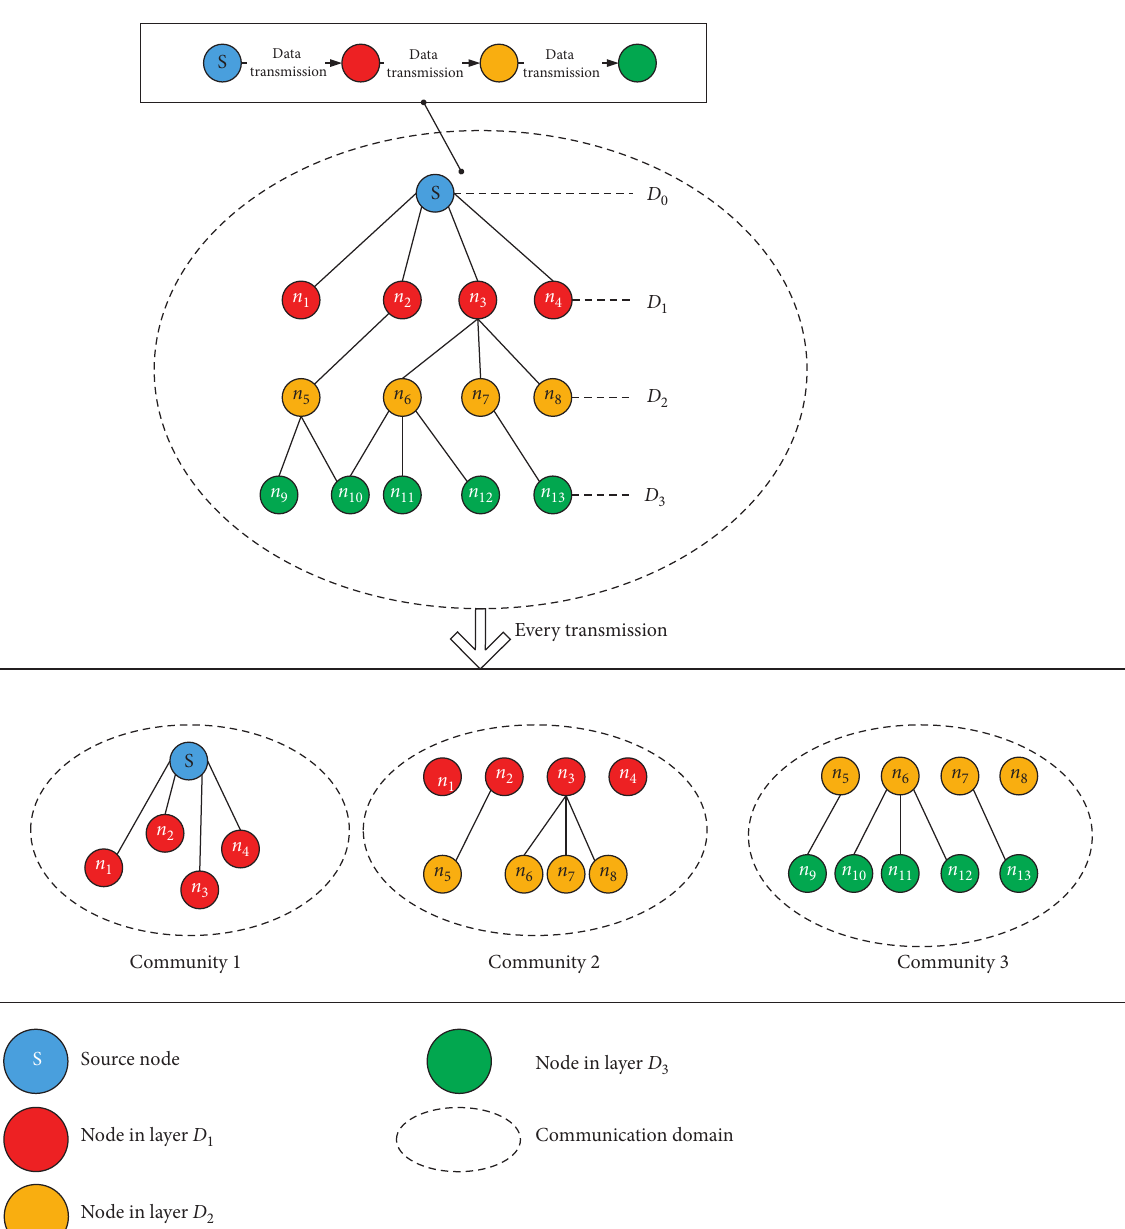
Figure 7: Broadcast tree and three